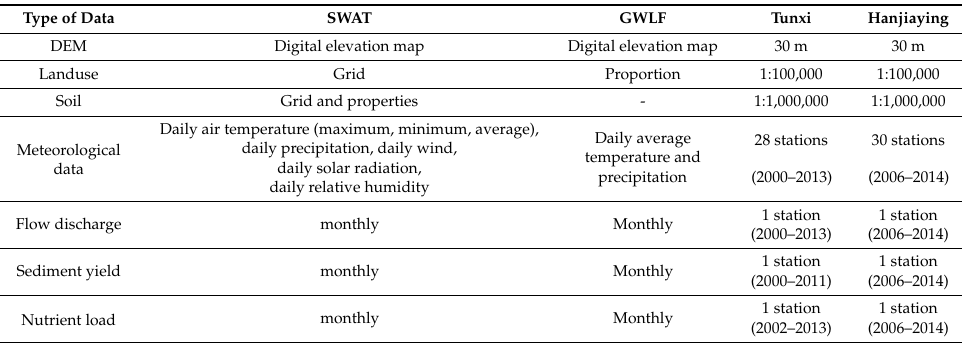
Table 2. Input data used in SWAT and